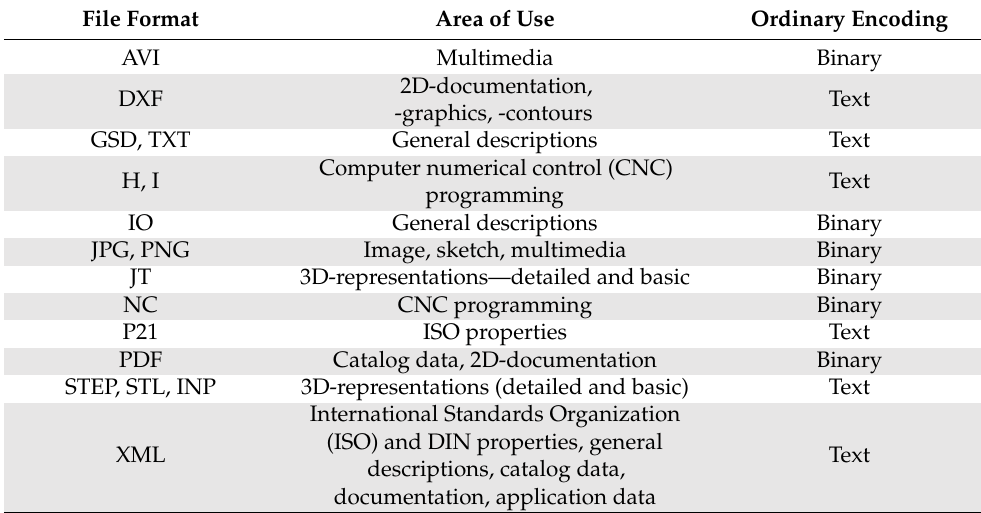
Table 1. Valid file formats in a container file per area of use, according to DIN 26100